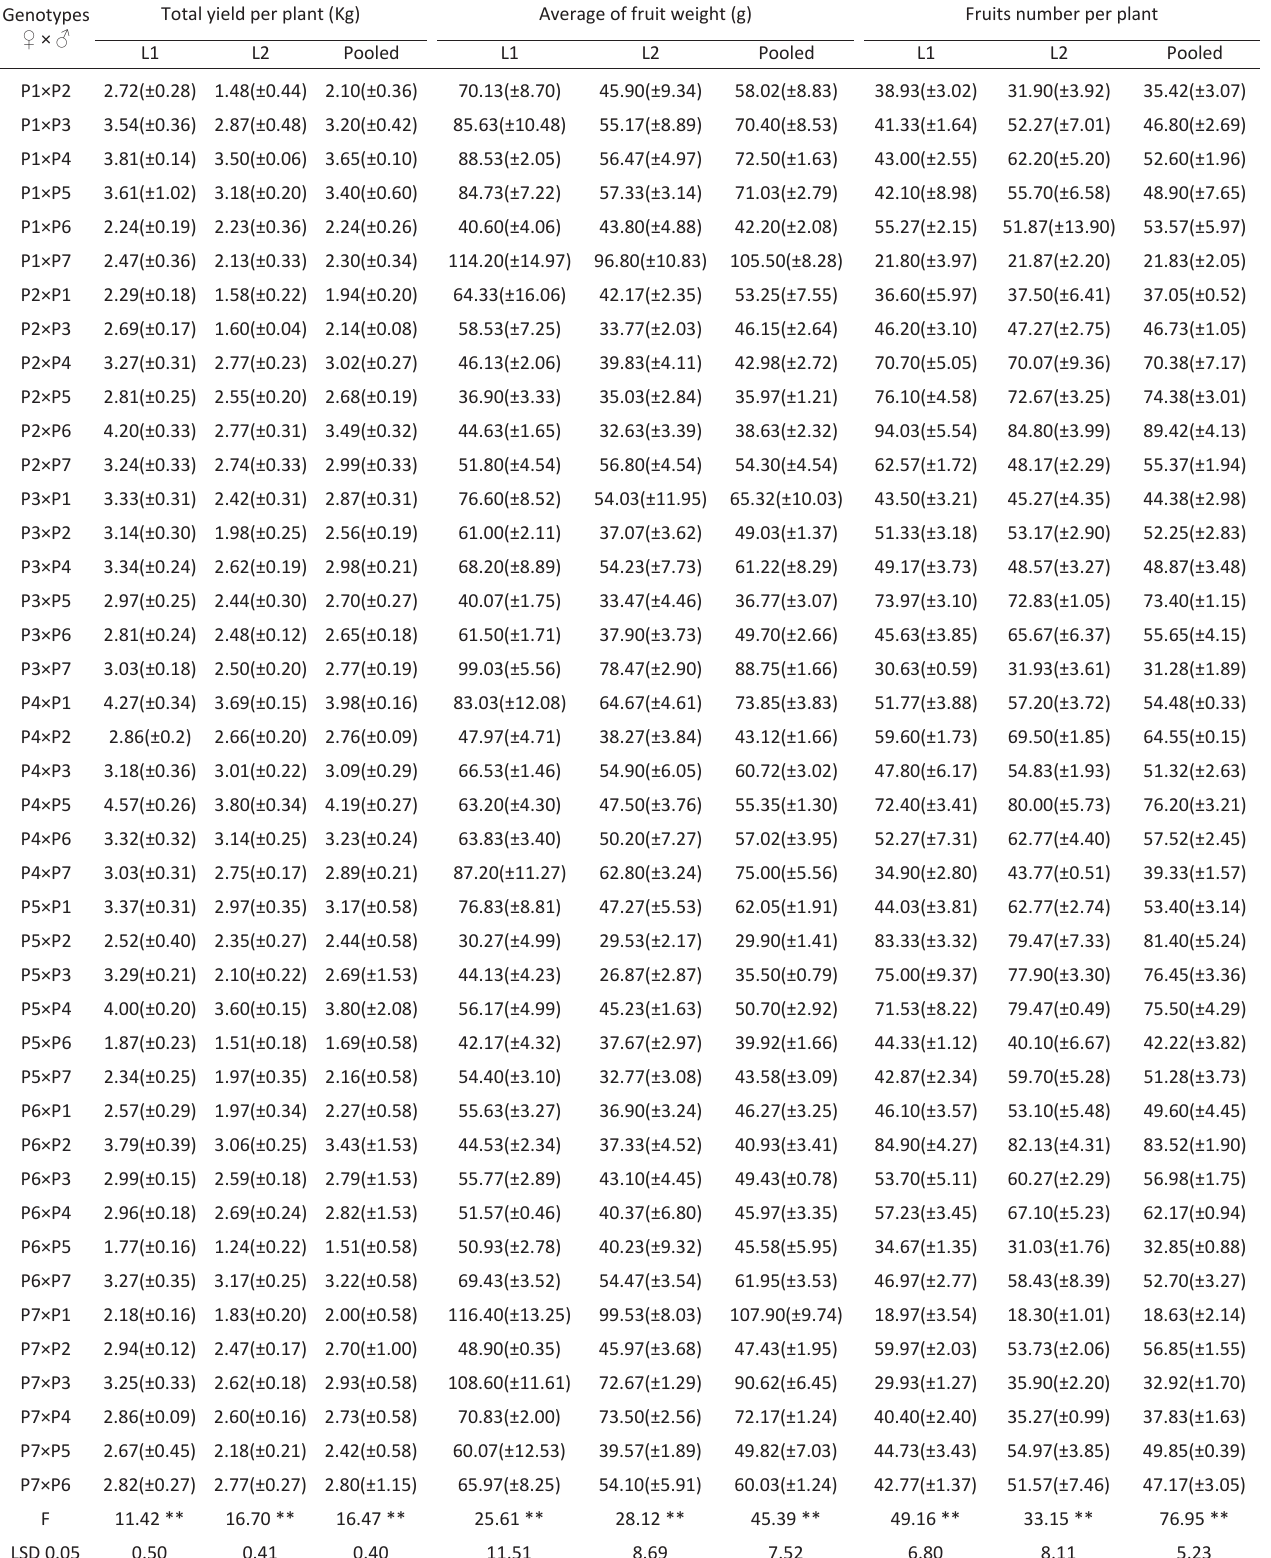
Table 5 - Means values and standard deviation for yield components and earliness of F1 hybrids developed via 7×7 diallel cross over two light conditions (part